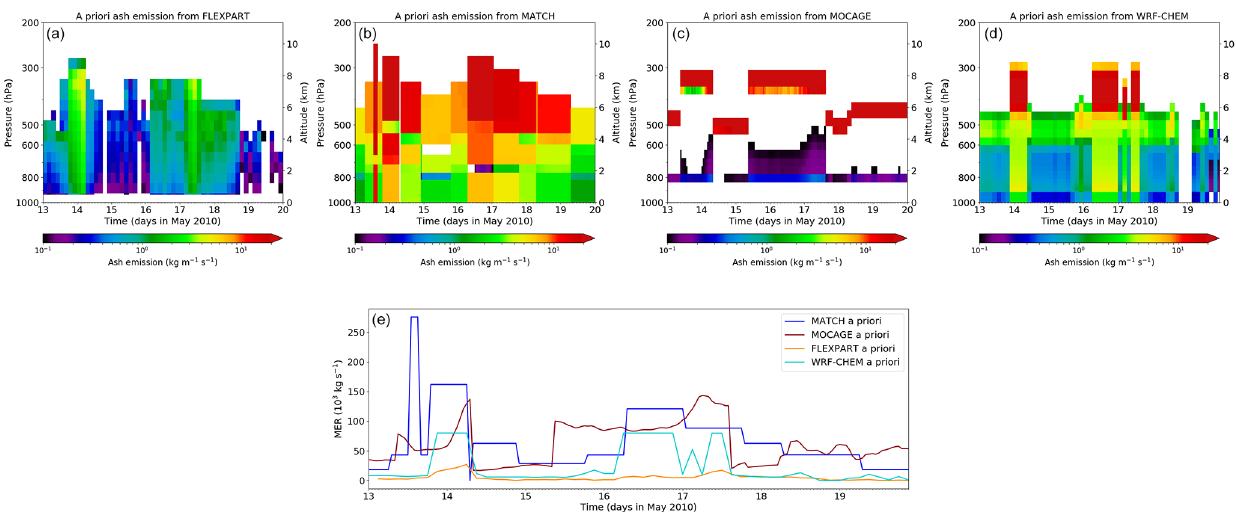
Figure 1. (a–d) A priori source terms used for FLEXPART, MATCH, MOCAGE, and WRF-Chem (from left to right). The source terms of fine ash are expressed in kgm − 1 s − 1 and are shown as a function of time and height. (e) Mass eruption rate (unit kgs − 1 ) for the four source terms, as a function of time.